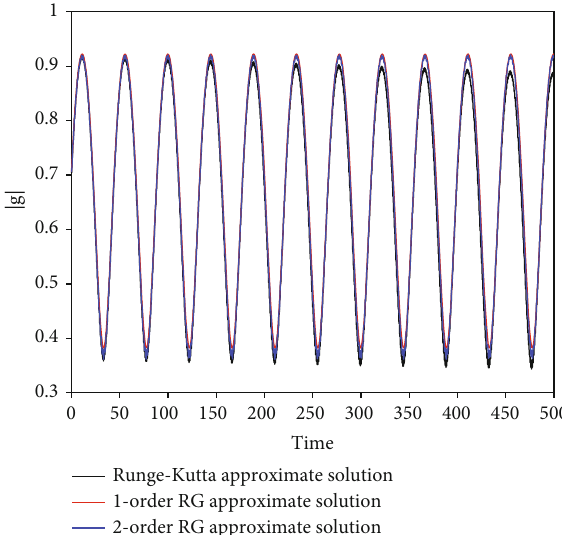
Figure 4: RG vs. Runge-Kutta approximate solutions of two-level systems in high-order quasiresonant